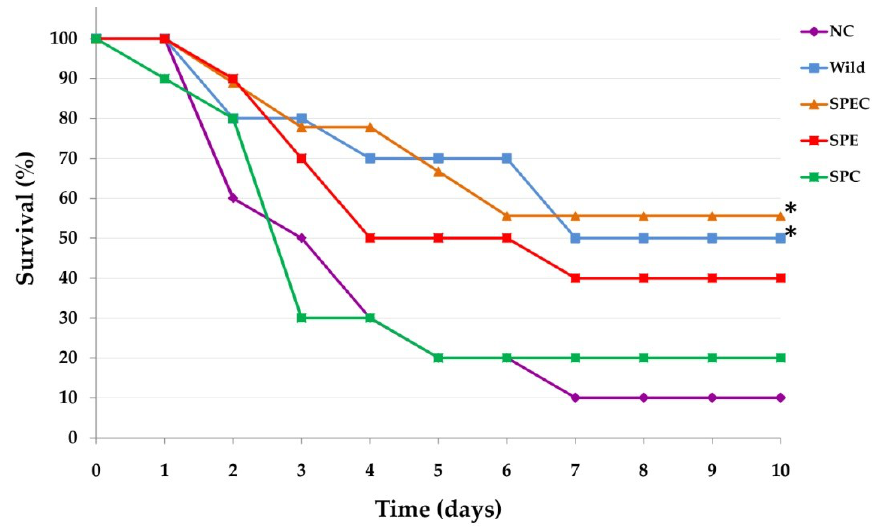
Figure 6. Survival rate (%) of vaccinated mice after exposure to a lethal dose ( ≈ 5 × 10 8 CFU) of intranasal wild-type S. pneumoniae D39 infection. Comparison of survival between groups of mice was analysed with the Log Rank chi-squared test on the Kaplan–Meier survival data. * pairwise comparisons show SPEC and wild strain immunised mice had significant differences ( p < 0.05) between SPC and mock immunised mice. Abbreviations used: NC, mice immunised with PBS; Wild, mice immunised with wild-type S. pneumoniae D39; SPE, mice immunised with S. pneumoniae D39 ( endA::aphA3 ) knockout mutant; SPC, mice immunised with S. pneumoniae D39 ( cpsE::tetL ) knockout mutant; SPEC, mice immunised with S. pneumoniae D39 ( cpsE::tetL ; endA::aphA3 ) double-knockout mutant.